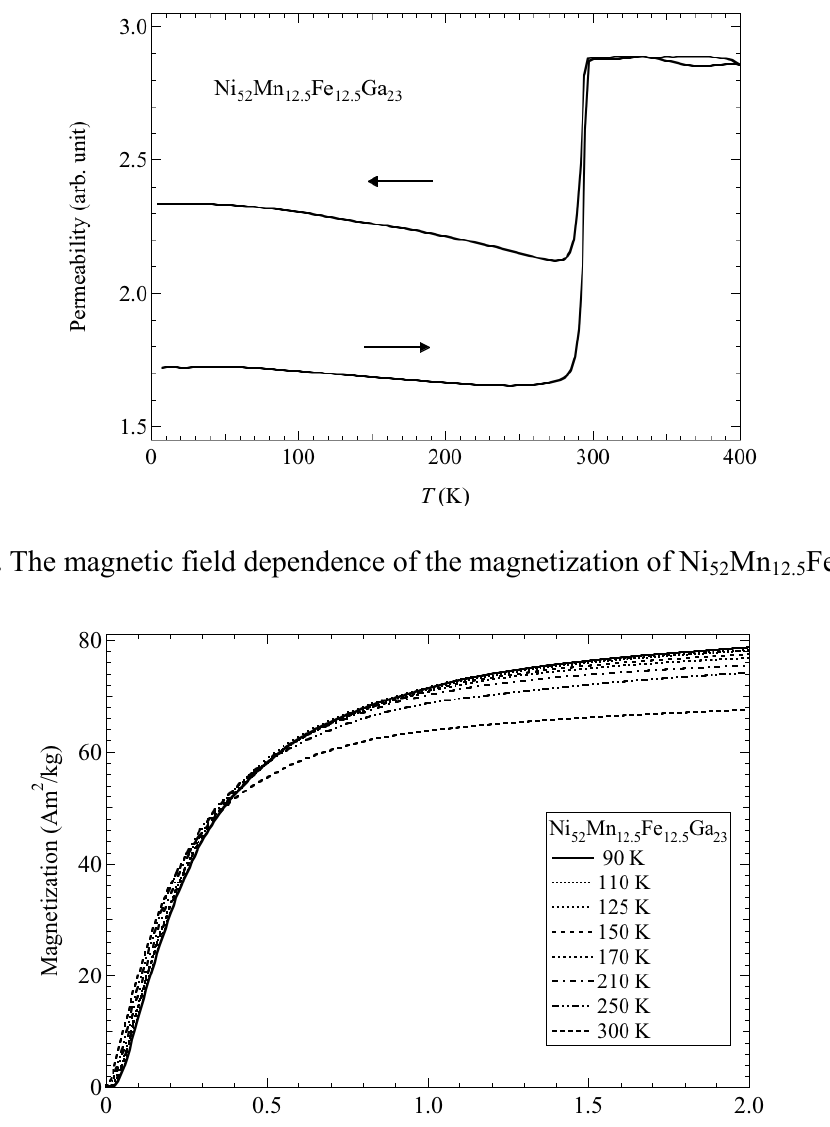
Mn Fe Ga . 52 12.5 12.5 23